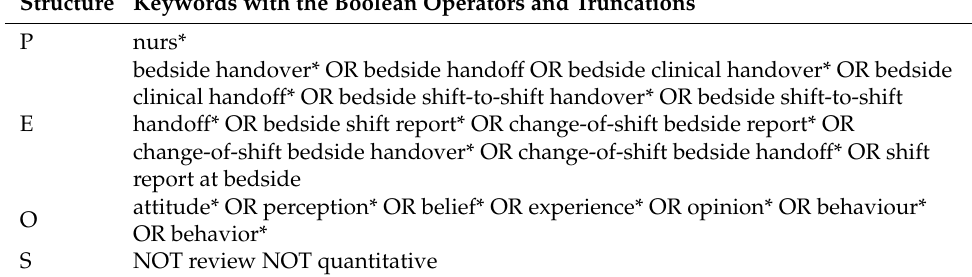
Table 1. PEOS framework and keywords. Structure Keywords with the Boolean Operators and